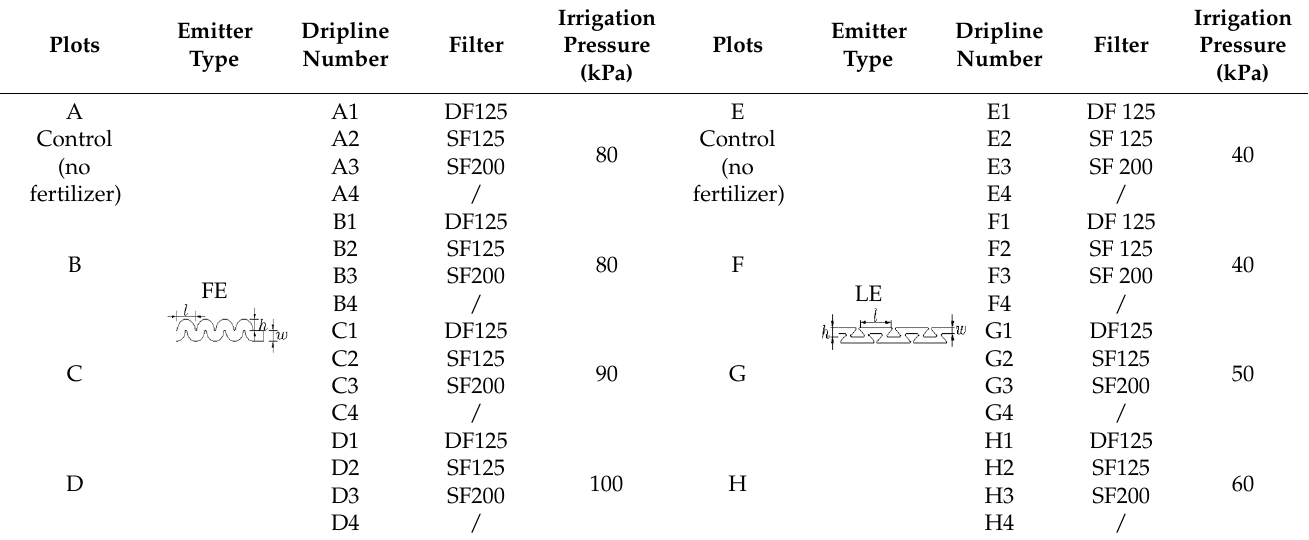
Table 3. Treatments and working conditions included in the experiments.